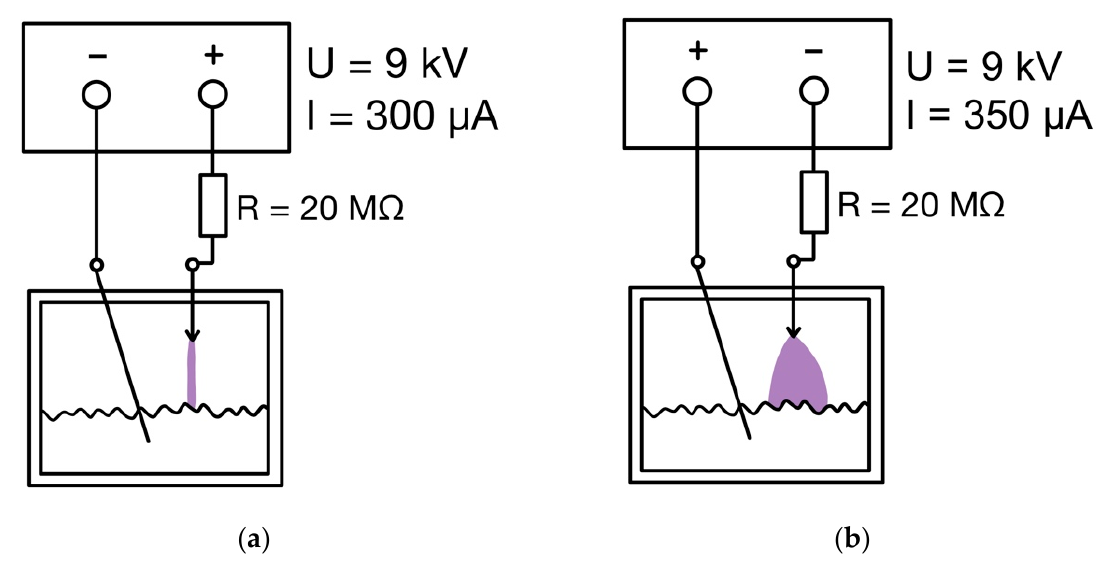
Figure 1. Wiring diagram of the apparatus for generating positive ( a ) and negative ( b ) discharge.